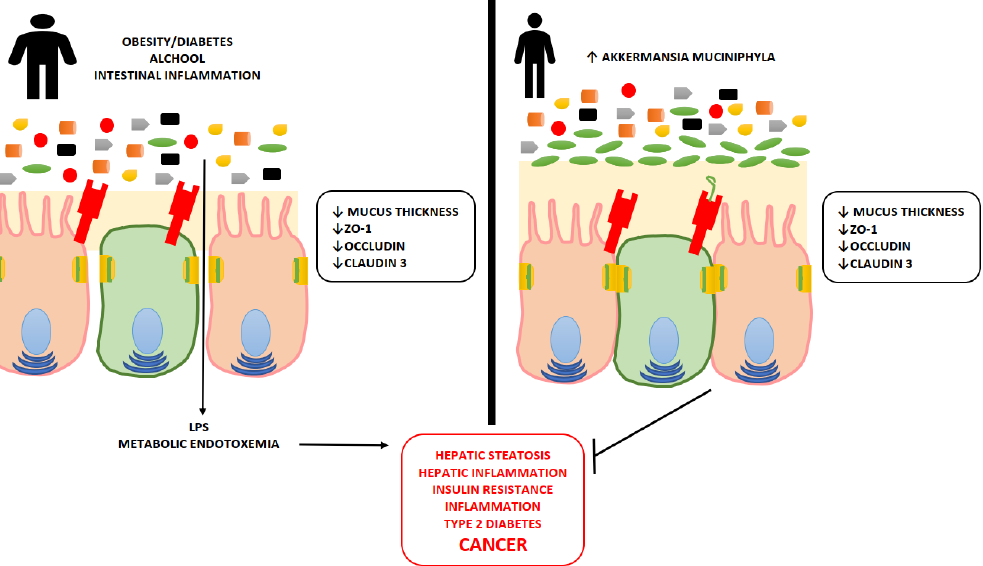
Figure 6. Action of Akkermansia mucciniphyla on mucus production and protection from pathogenic and inflammatory bacteria.